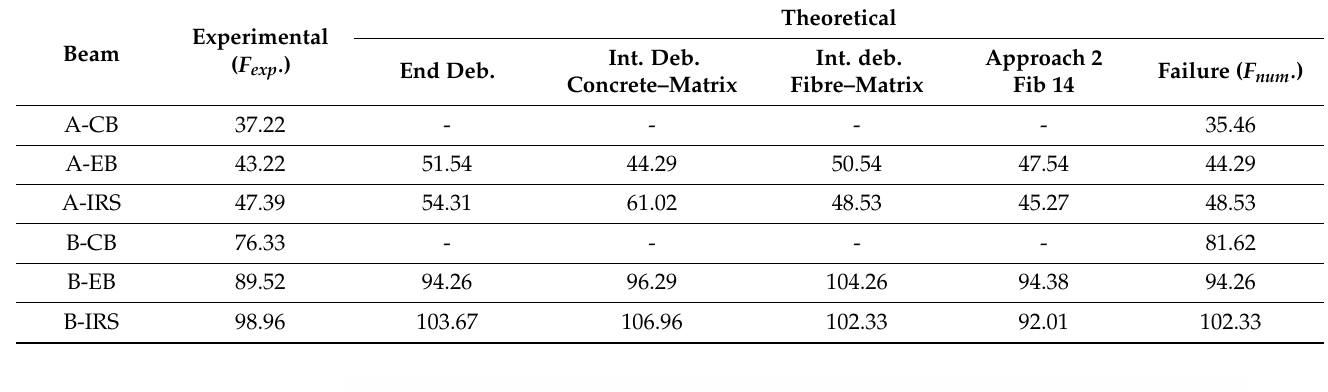
Table 3. Debonding/Ultimate load values (kN).